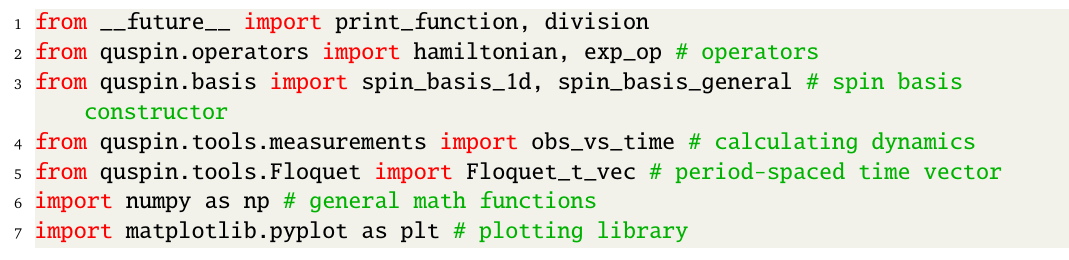
Figure 6: Comparing the dynamics of Q ( t ) (a) and S 2 d (blue) at stroboscopic times ( t = nT ). Both systems contain N = 16 sites to make sure the many-body Hilbert spaces have roughly the same number of states. s normalized by the Page entropy per site. The drive frequency is Ω =